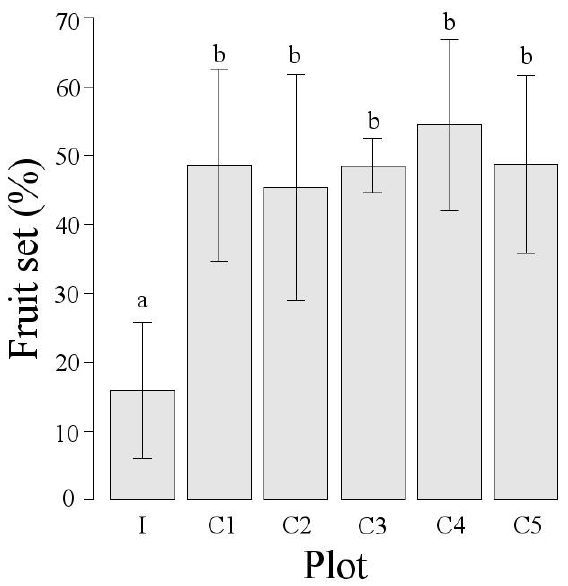
F IGURE 2. Comparison of the percentage of fruit set (Mean ± SD) between plots whose flowers were attacked by T. amalthea (I = infested plot) and plots without attacks from this species (C1 – C5 = control plots). Bars with different letters are significantly different according to the Bonferroni post hoc adjustment for multiple comparisons P < 0.05 (See data in Supplementary Table